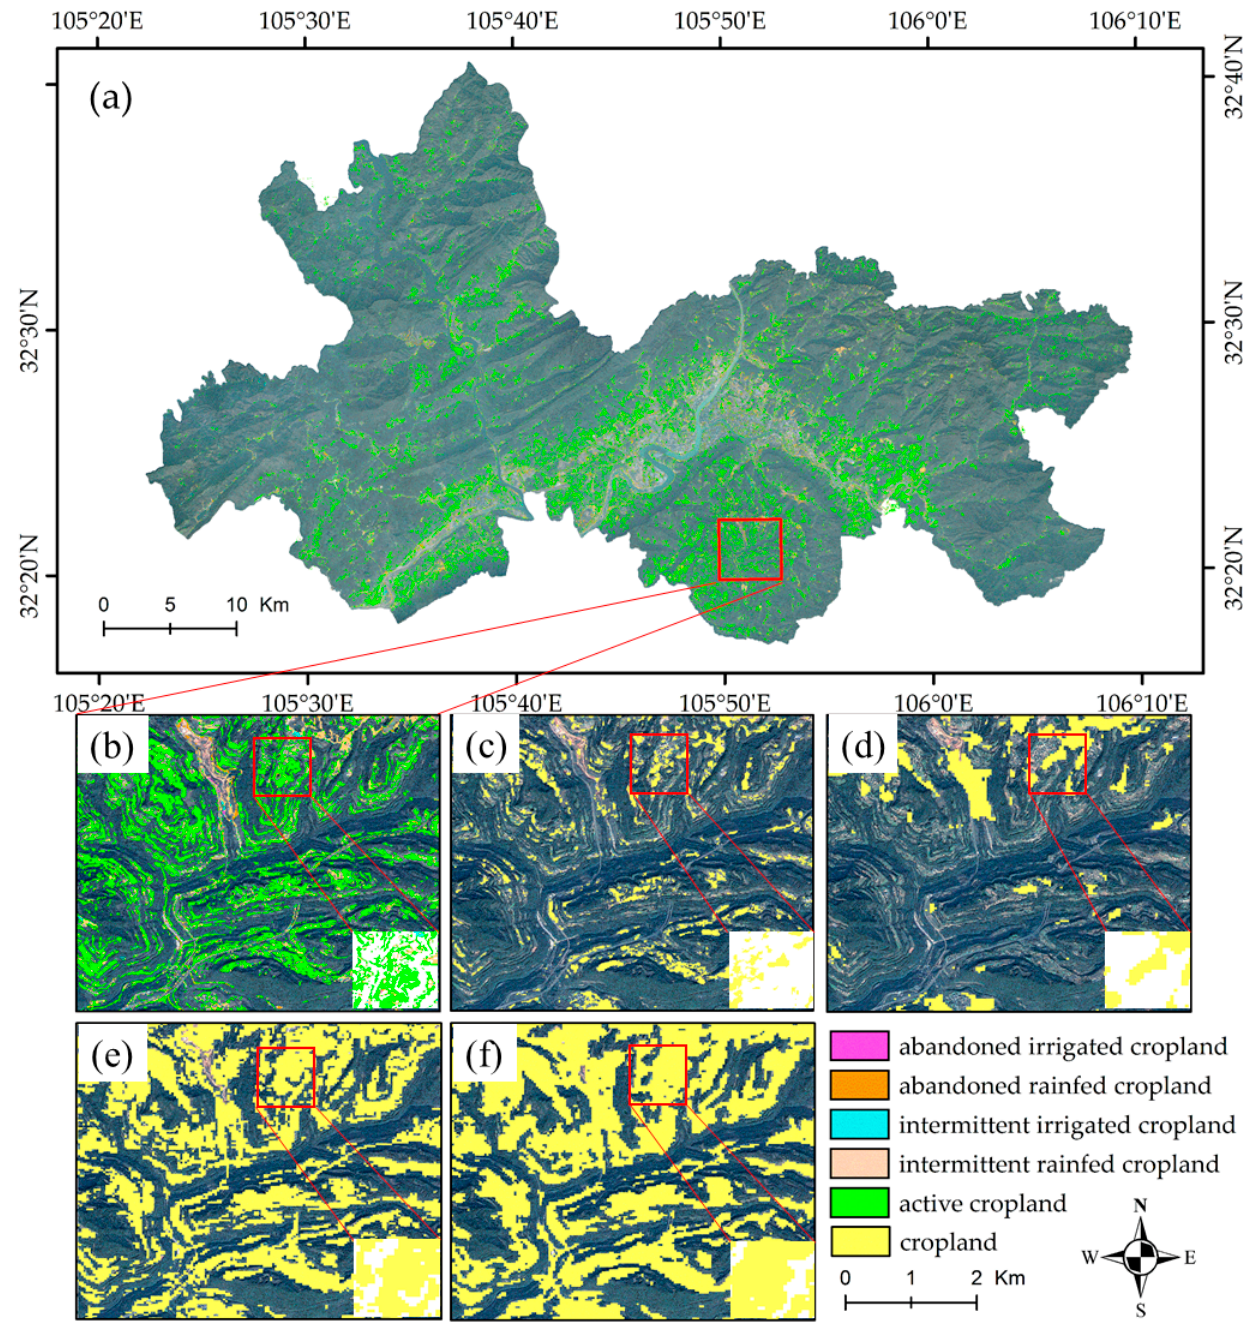
Figure 5. Spatial distribution map of cropland abandonment, using GF-2 imagery as the background. Abandoned irrigated cropland/abandoned rainfed cropland, intermittent irrigated cropland, intermittent rainfed cropland, and active cropland were the classes considered. ( a ) Spatial distribution map of rules including active cropland, intermittent irrigated cropland, intermittent rainfed cropland, abandoned irrigated cropland, and abandoned rainfed cropland in the study area. ( b ) Partial enlargement of ( a ). ( c – f ) Corresponding partial enlargements of the ESA WorldCover 2020 land cover product, the global ESRI 2020 land cover product, the GLC_FCS30 in 2020, and the CLCD in 2020; yellow represents the spatial distribution of cropland.